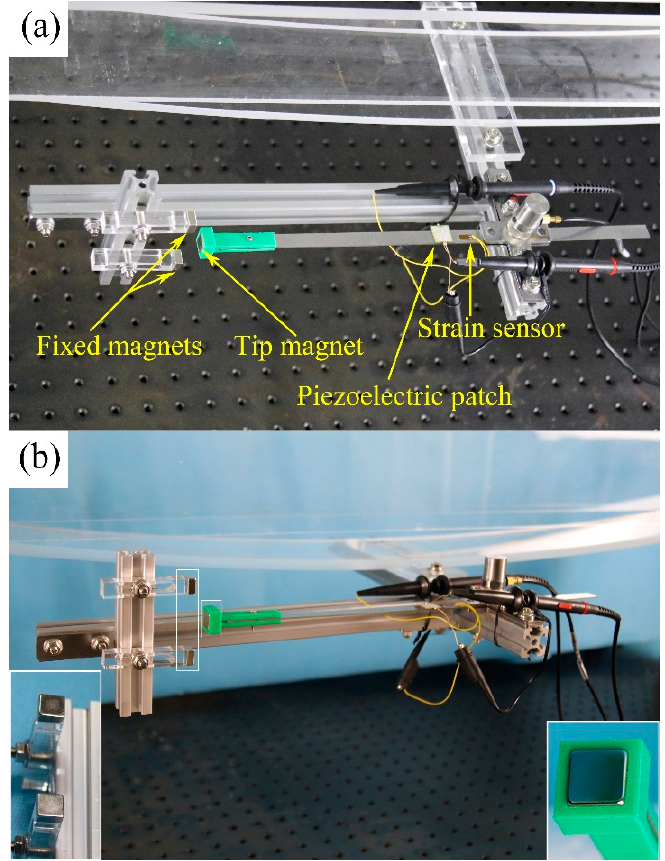
Figure 6. Prototype of the MPEH: ( a ) top view and ( b ) side view.